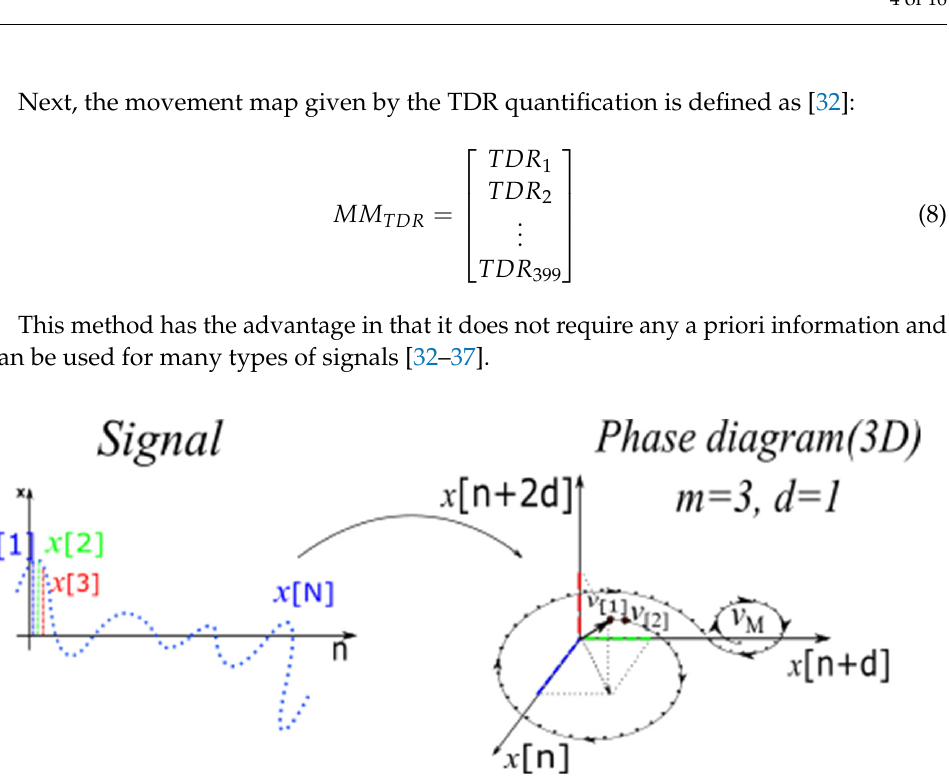
Figure 1. Illustration of the phase diagram concept.